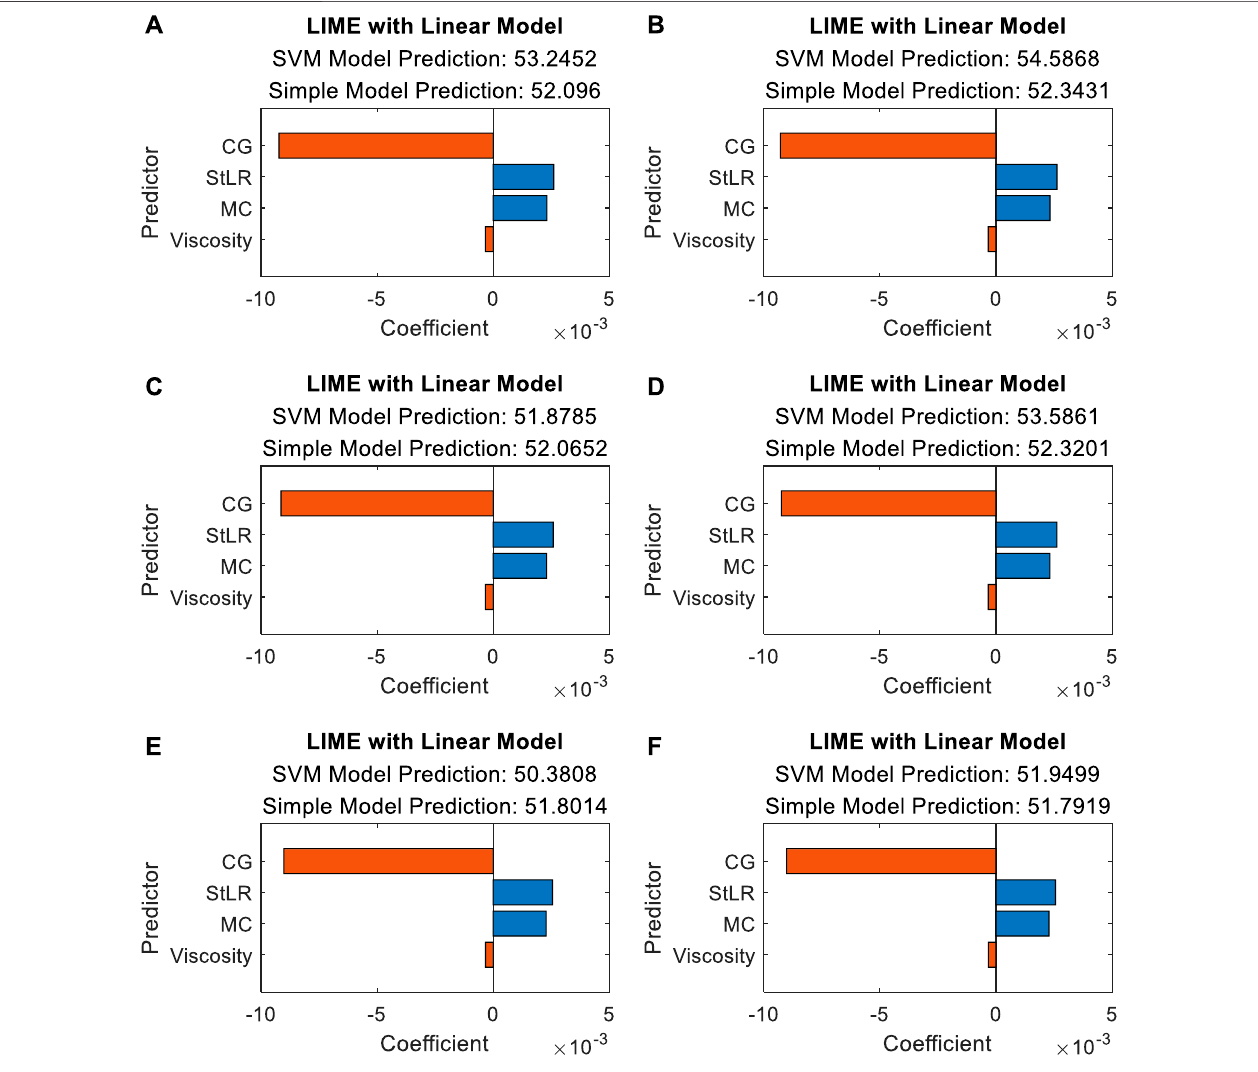
FIGURE 5 | Parameter effect analysis results using LIME with the linear model for six query points: (A) query point 1, (B) query point 2, (C) query point 3, (D) query point 4, (E) query point 5, and (F) query point 6.